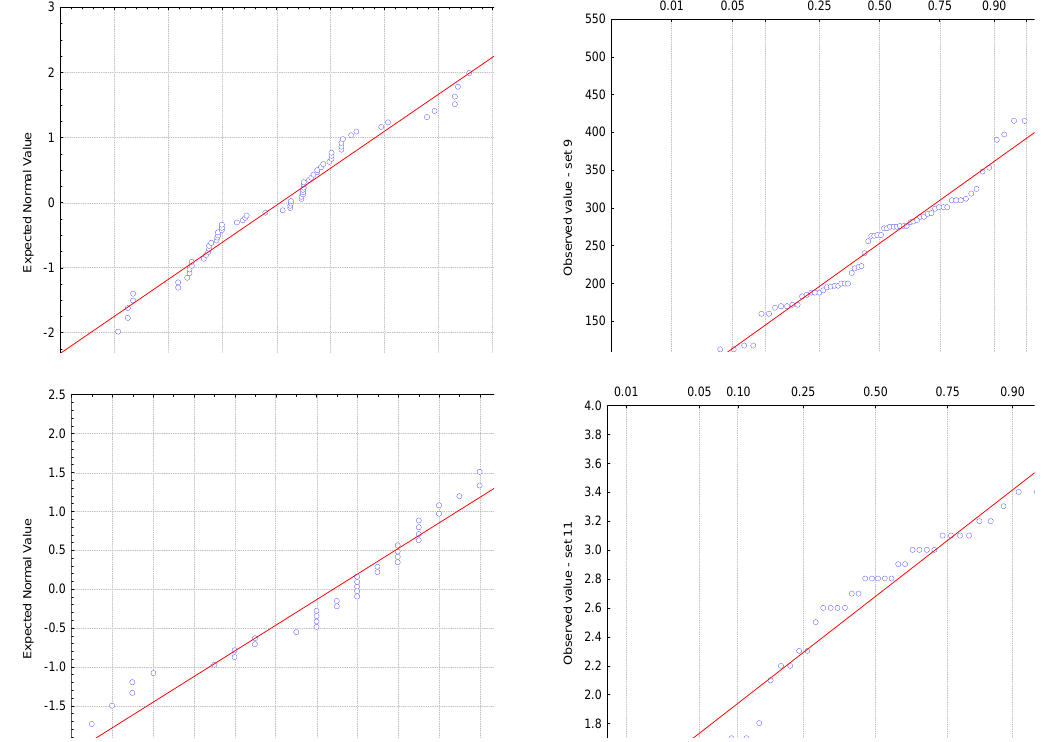
Figure 6. Normal probability plots (P–P) and quantile-quantile plot (Q–Q) by example: graphs for set 9 ( n = 70) in the first row, and for set 11 ( n = 40) in the second row.